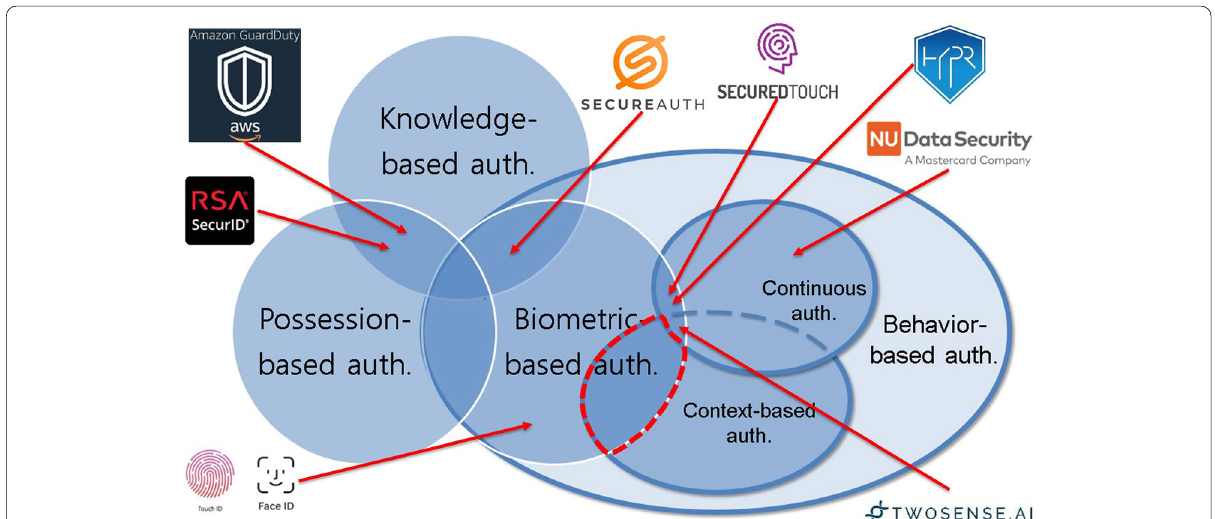
Fig. 1 Landscape of authentication solutions for mobile devices. Despite high usability, the domain of context-dependent behavior-based authentication (marked with dashed red line) does not attract much attention yet